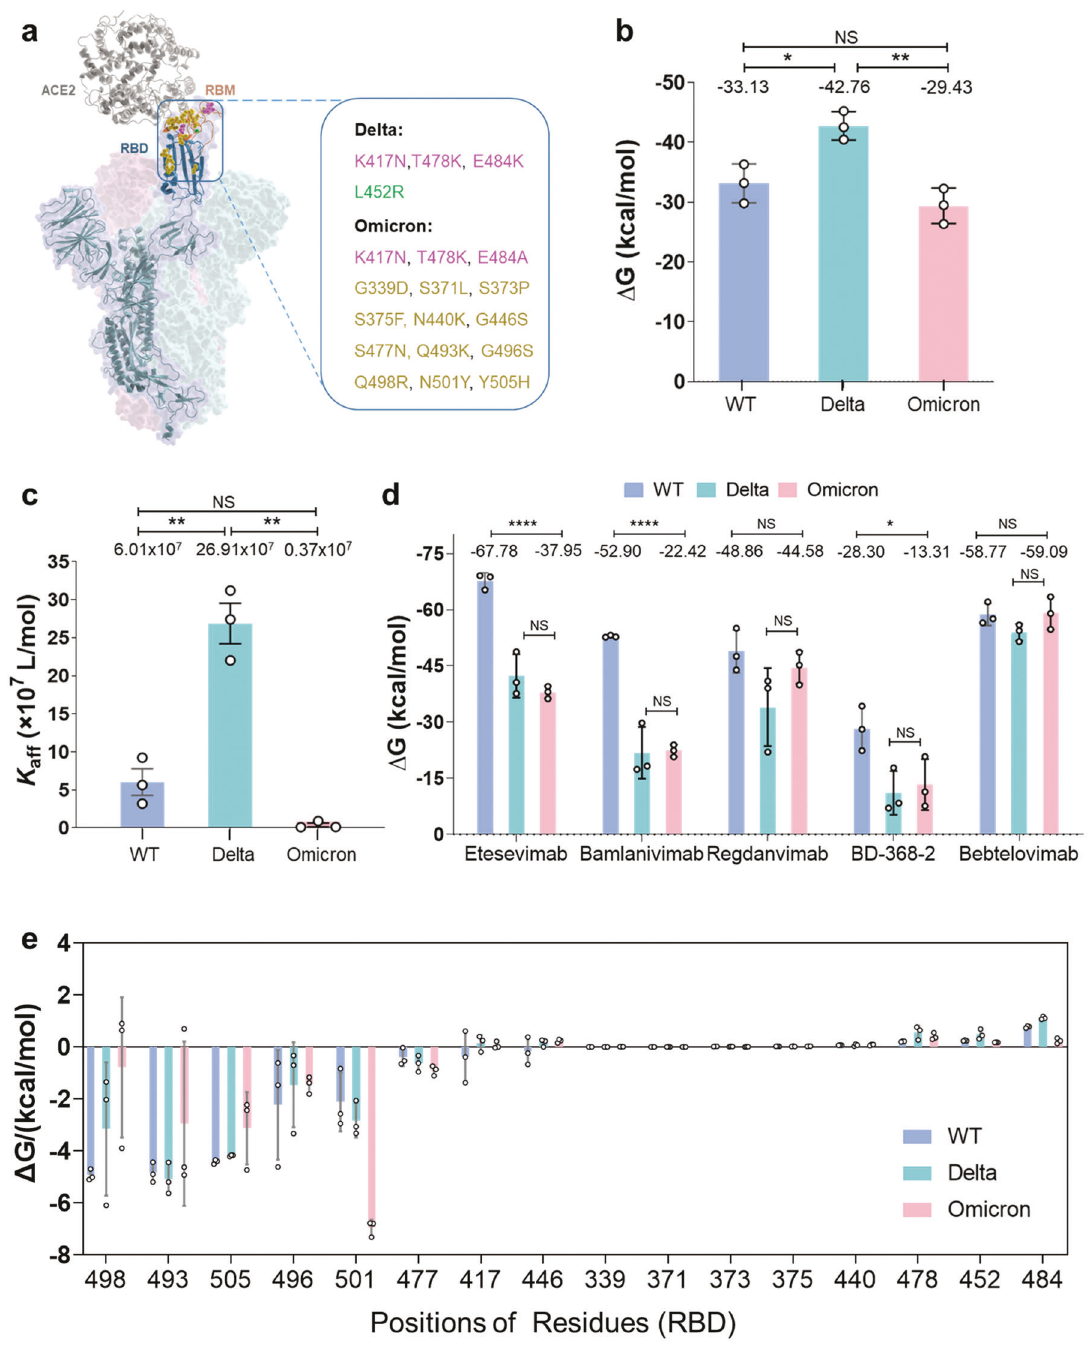
Fig. 1 Binding af fi nity of ACE2 to the RBDs of WT, Delta and Omicron variants. a Mapping SARS-CoV-2 RBD mutations on the three- dimensional structure. The spike protein trimer is shown as surface. Identical mutations sites in both Delta and Omicron variants are shown as magenta. Other RBD mutations in Delta and Omicron variants are shown as green and yellow, respectively. b The predicted ACE2-RBD binding free energy (kcal/mol) of WT, Delta and Omicron variants. c RBD-ACE2 af fi nity constants measured by ELISA. d The predicted mAb-RBD binding free energy (kcal/mol) of WT, Delta and Omicron variants. e Energy contributions of 16 RBD mutations in Delta or Omicron variants. NS, not signi fi cant; * P < 0.05, ** P < 0.01, *** P < 0.001, **** P < 0.0001 effect of the multiple mutations of Omicron on its similar binding are weaker than that in WT (Fig. 1e), while that of Y501 in Omicron free energy to RBD WT , while the strong binding free energies of is greatly stronger than N501 in WT. The opposite effects make the change of interaction between RBD Omicron and ACE2 very RBD Delta to ACE2 could be attributed to the hydrophobic complicated, but fi nally resulting in a similar binding af fi nity of interaction from the residues of F486, Y489 and F490 (Supple- RBD Omicron -ACE2 to that of RBD WT -ACE2. The detailed interaction mentary Fig. S8). In conclusion, both MD simulation and ELISA bioassay results mechanism and contributions are summarized in Supplementary suggest that Omicron variant possesses comparable binding Figs. S5 and S7 and discussed in. In overall, it is a combinatorial Signal Transduction and Targeted Therapy (2022)